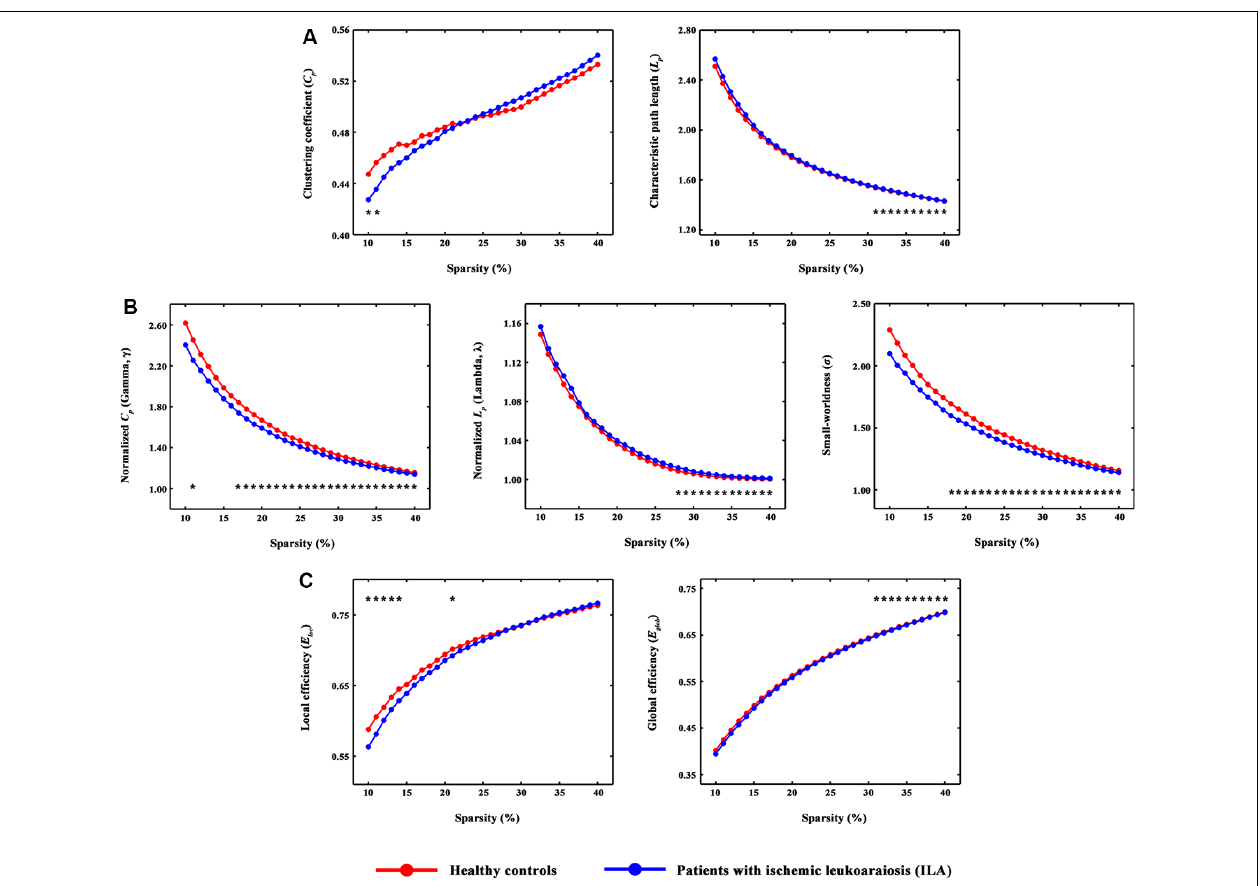
FIGURE 1 | The small-world parameters and network efficiency of whole-brain functional networks. Black asterisks ( ∗ ) indicate a significant difference between the ILA and HC groups (permutation testing, P < 0.05). (A–C) The ILA patients showed abnormal global topology in their functional brain networks (i.e., increased absolute and normalized path lengths, and decreased small-worldness and network efficiency), suggesting a less optimal topological organization in ILA. HC, healthy control; ILA, ischemic leukoaraiosis.